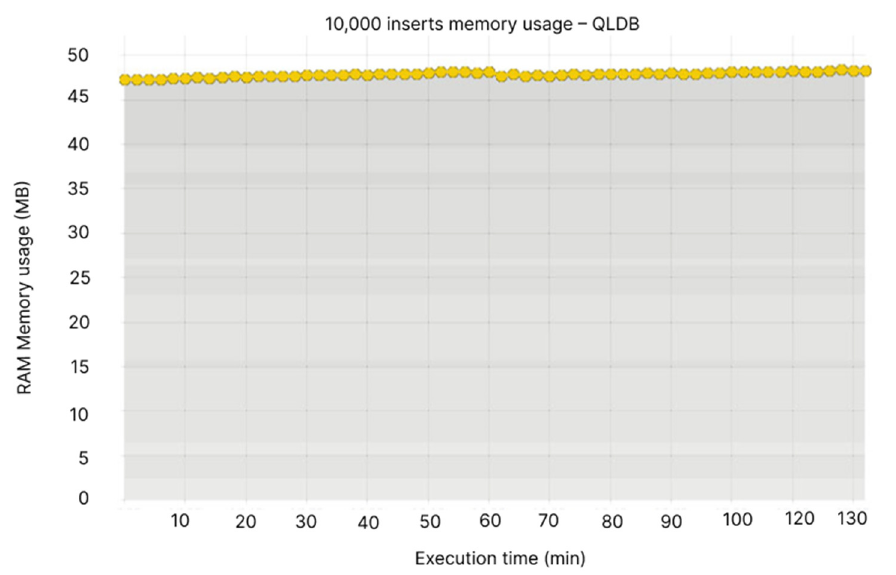
Figure 17. 10,000 inserts memory usage—QLDB.